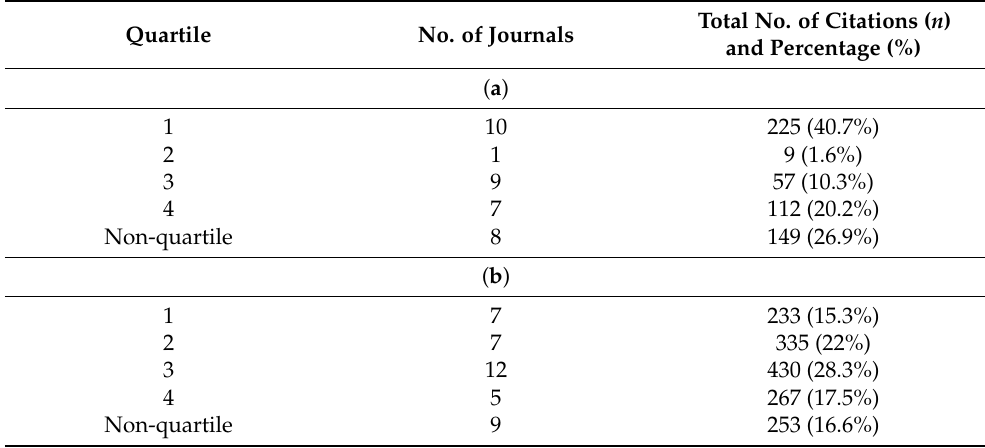
Table 5. (a): Number and citations of research articles as per quartile in regard to RULA. (b): Number and citations of research articles as per quartile in regard to NMQ.